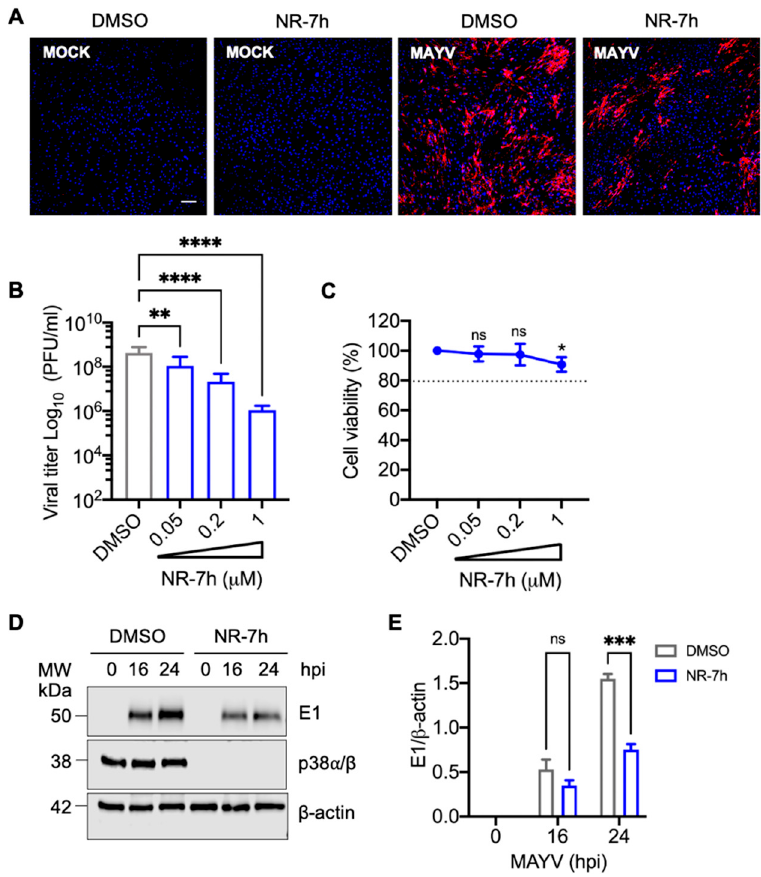
Figure 6. Chemically-induced degradation of p38 α and p38 β isoforms using the PROTACs com- pound NR-7h affects MAYV replication. ( A ) HDFs were pre-treated with DMSO or NR-7h at 1 µM for 3 h and then the cells were infected with MAYV as previously indicated. After 24 h of infection, MAYV antigen-positive cells were analyzed using an immunofluorescence assay as previously stated. Cell nuclei were stained with Dapi. Images were obtained with a confocal microscope and analyzed with ImageJ software. Scale bar, 100 µm. ( B ) HDFs were pre-treated with increasing concentrations of NR-7h and then infected with MAYV as previously performed. After 24 h of infection, viral progeny production in cell supernatants was assessed using plaque assay. Viral titers were expressed as plaque-forming units per milliliter (PFU/mL). ( C ) HDFs were treated with the indicated concentrations of NR-7h for 24 h and then cell viability was estimated as previously performed. The dotted line on the graph indicates a cell viability of 80%. ( D ) HDFs were pre-treated with NR-7h and then infected as stated above. At several time points, viral E1 or p38 α /p38 β protein levels were analyzed using immunoblot. Β -actin protein was used as a loading control. MW: molecular weight. kDa: kilodaltons. ( E ) Intensity bands of viral E1 protein were analyzed with ImageJ software and normalized with Β -actin protein. Data were analyzed with the One- or Two-way ANOVA test followed by Dunnett’s or Sidak’s post-test. Statistically significant differences are denoted: * p < 0.05; ** p < 0.01; *** p < 0.001; **** p < 0.0001 and ns: non-significant.